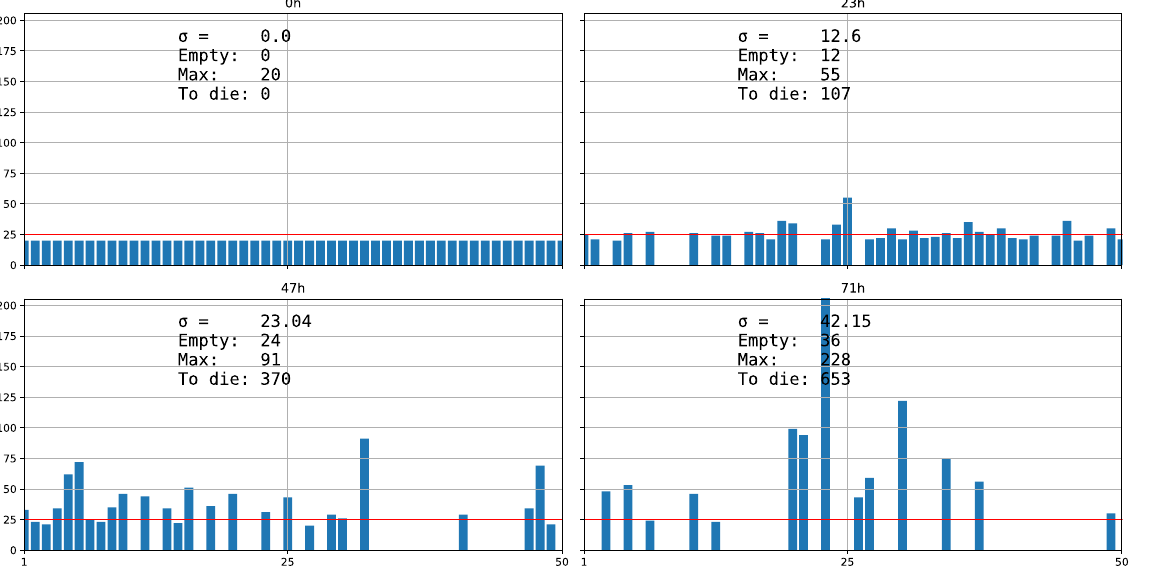
Figure 4. Strategy h . It is similar to r distribution (Figure 2) but with the percentage of empty cells that its prefix indicates (Empty in the figure).